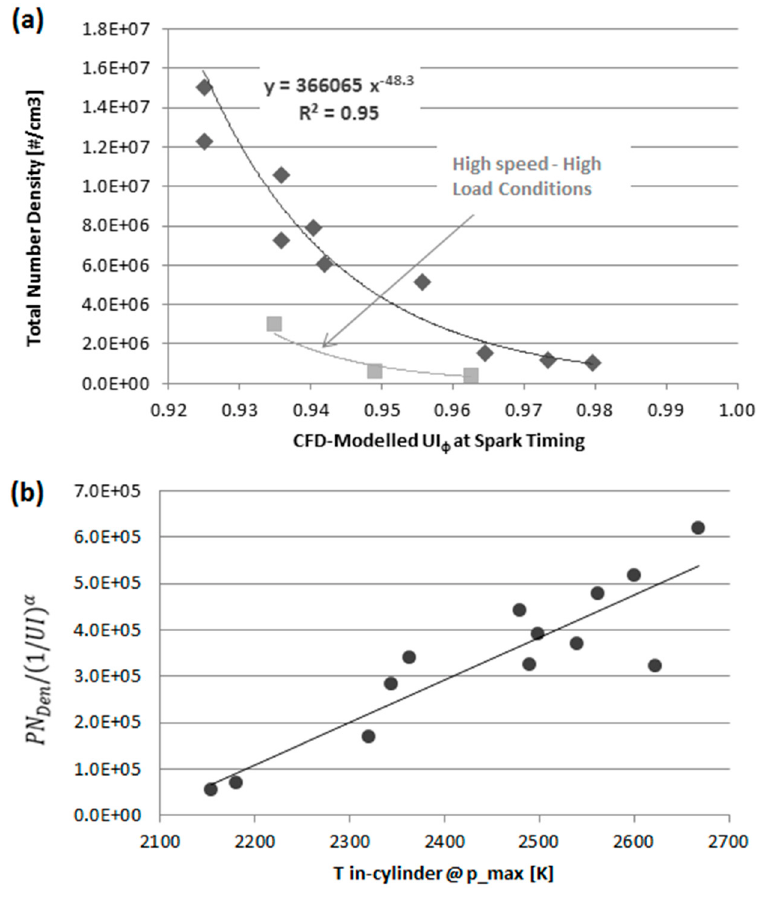
Figure 11. ( a ) Total particle number density as a function of CFD-modelled uniformity index of equivalence ratio calculated at spark timing; and ( b ) normalised total number density as a function of gas temperature calculated at the location of peak pressure.